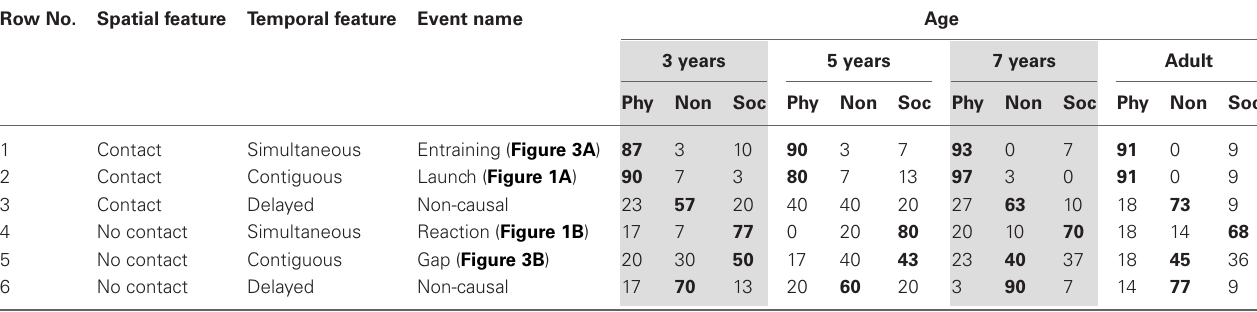
Table 2 | Percentage of physically causal, non-causal, and socially causal attributions, in 4 age groups, for 6 events varying spatial and temporal features factorially in Experiment